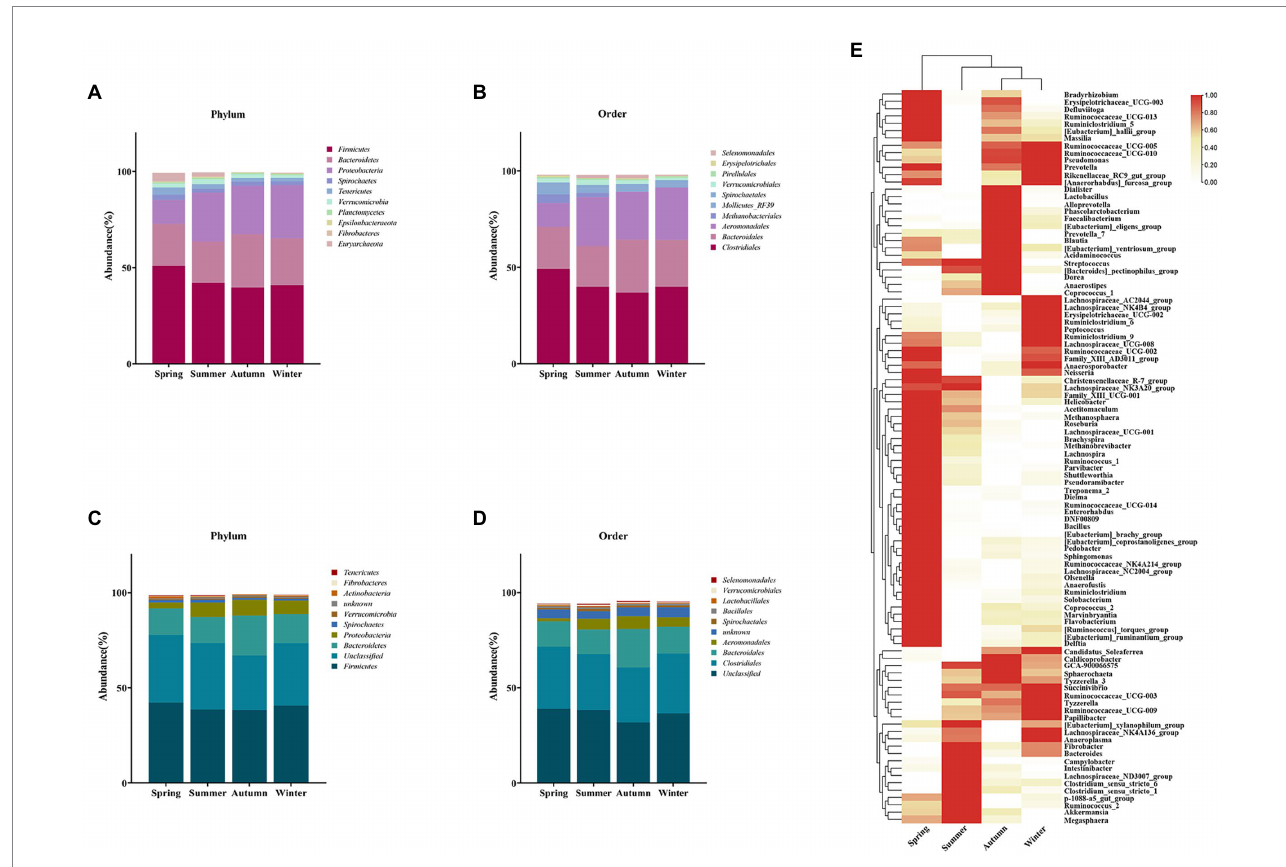
FIGURE 4 Analysis of seasonal differences in dominant bacterial populations. Relative abundance of dominant phylum (A) and order (B) in four seasons based on 16S rRNA gene pools. In contrast, macrogenome annotation of dominant bacteria at the level of phylum (C) and order (D) . Heat map of proportions at the genus level (E) , the darker the color, the higher the proportion of this genus present in the season compared to other seasons.